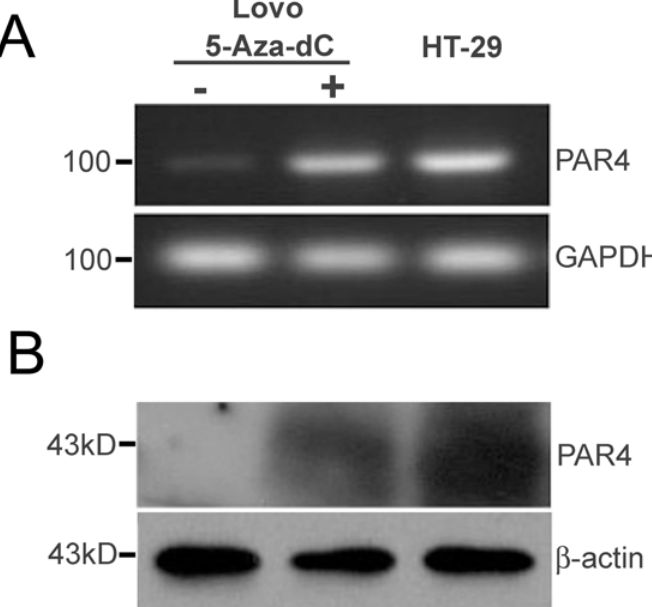
Fig 6. 5-Aza-dC induced PAR4 expression in colorectal cancer cell, LoVo. LoVo, a non- PAR4 expressing cells, were incubated with 5-Aza-dC (10 μ M) or DMSO for 72 hours, and the cells were used to extract mRNA and protein. (A) The expression level of PAR4 mRNA was examined by RT-PCR; (B) The expression level of PAR4 protein was examined by western blot. The colorectal cancer cell line HT-29 expressed PAR4 was used as a positive control.